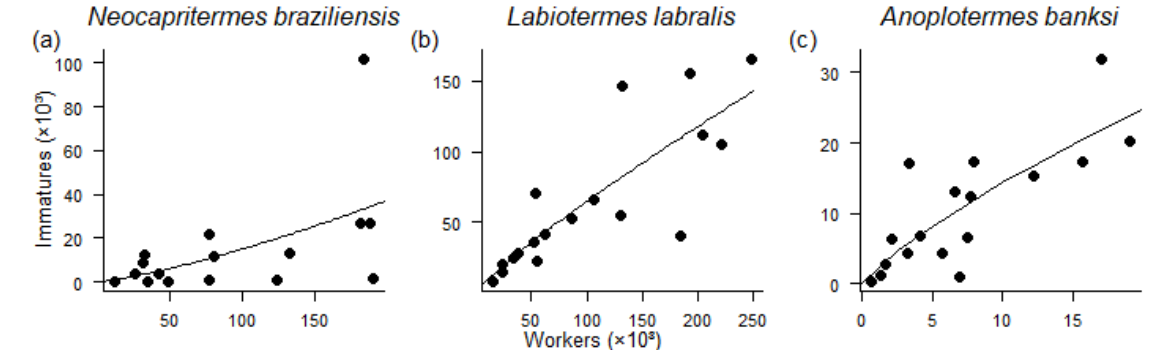
Fig 2 . Whole-colony scalings of growth in three Amazonian termite species. Points represent colonies. Solid lines represent statistically significant GLM fits at the 0.05 level, as indicated in Table 2.